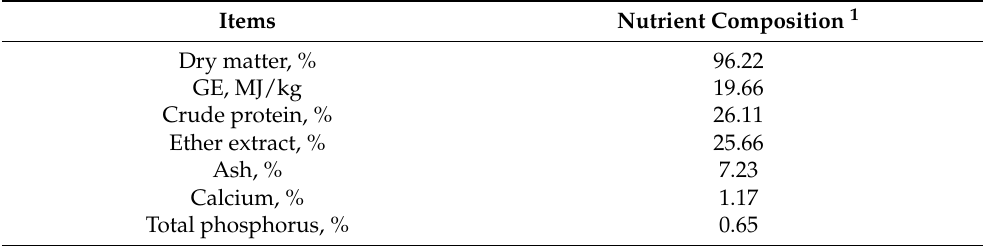
Table 1. Ingredients and nutrient compositions of milk replacer powder (feed basis,